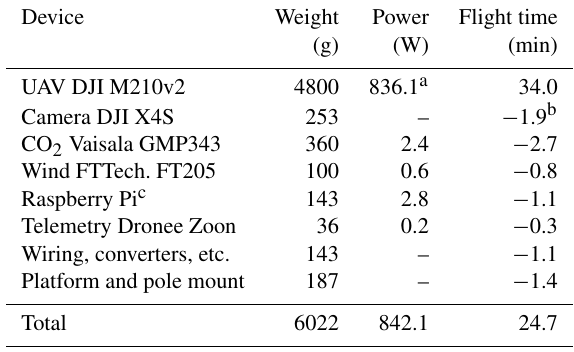
Table 1. UAV and instrumentation: weight, power consumption, and contribution to flight time. The reduction in flight time results from the weight and the power consumption of the